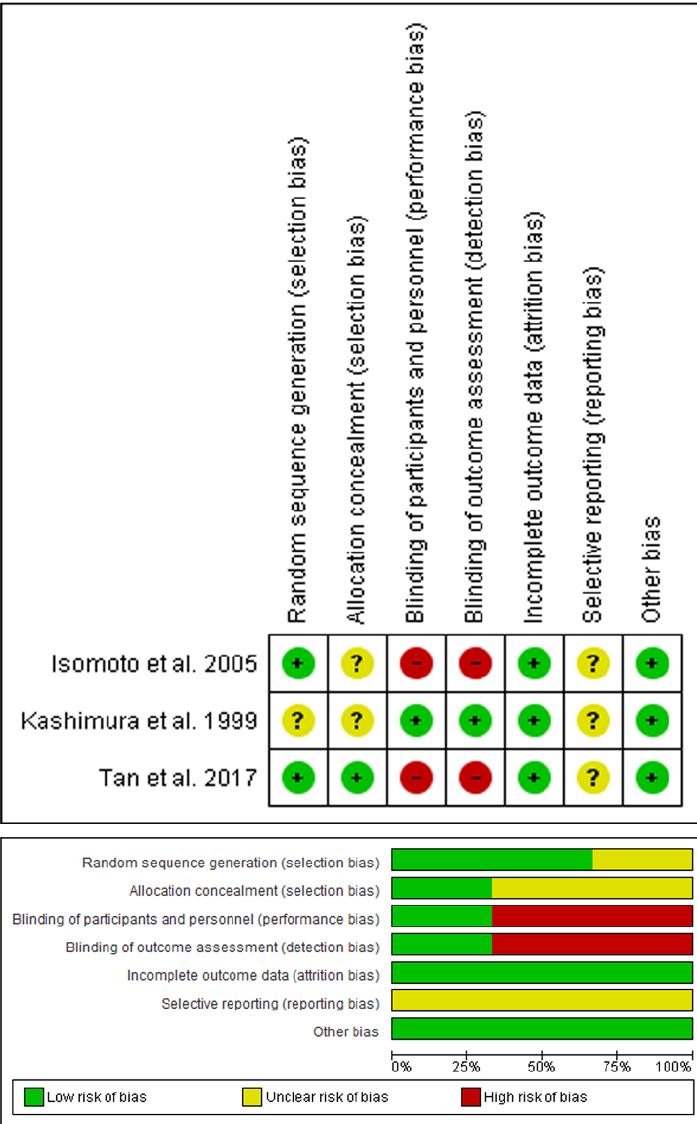
Figure 3. Quality assessment of risk of bias in the studies in the meta-analysis. The upper panel presents a schematic representation of risks (low = red, unclear = yellow, and high = red) for specific types of biases of each of the studies in the review. The lower panel presents risks (low = red, unclear = yellow, and high = red) for the subtypes of biases of the combination of studies included in this review [50].